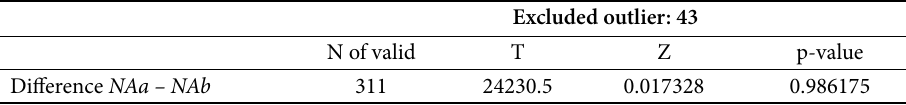
Table 3. Wilcoxon paired test at significance level p < 0.05